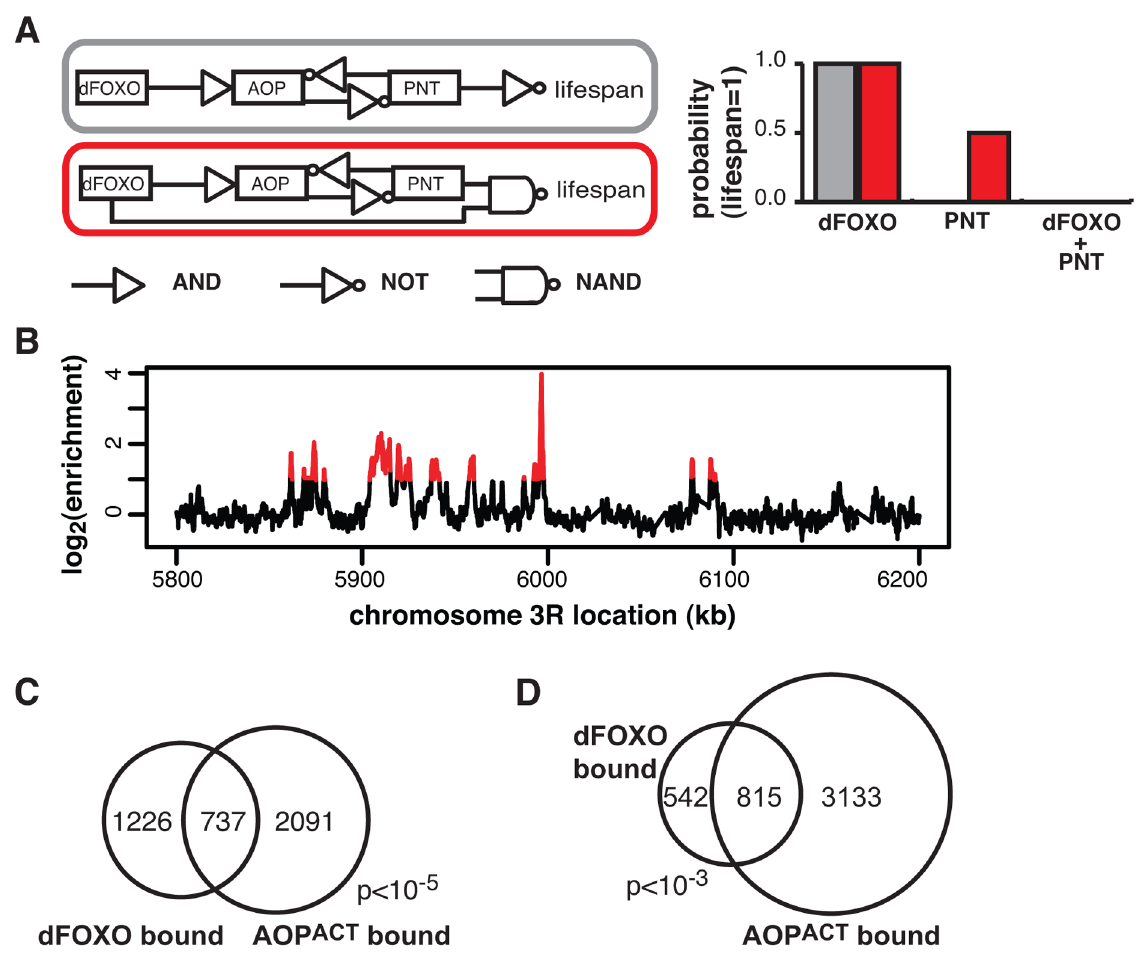
Figure 5. dFOXO and AOP ACT share binding sites across the genome. A Boolean network models of dFOXO-AOP-PNT-lifespan interaction. The linear model is indicated in grey and the feedforward model in red. The logic gate symbols for AND, NOT and NAND (NOT AND) are used, and in the case shown NAND means that only the combined effect of dFOXO and PNT is detrimental to lifespan. For each model the probability of a positive outcome for lifespan (lifespan=1; y axis) after 1000 state transition was determined using Markov chain simulations after fixing either dFOXO or PNT or both as active (=1; x axis). Only the feedforward model can capture the synergistic negative effects of the two TFs. B ChIP-chip traces, showing the enrichment (log 2 -transformed) of the FLAG-AOP ACT -immunoprecipitated DNA over total chromatin, are averages of three biological repeats after subtraction of the mock control and are shown over a region of chromosome 3R. Red denotes the enrichment associated with peak regions. C Proportional Venn diagram showing the overlap between the genes in the vicinity ( , 1 kb) of GFP-dFOXO or FLAG-AOP ACT binding in the gut/fat body (Hypergeometric test, p , 10 2 5 ). D Proportional Venn diagram showing the overlap in GFP-dFOXO-bound and FLAG-AOP ACT -bound genomic sites. Note that the average overlap is shown, since one peak in one set can overlap multiple peaks in the other due to differing peak lengths: 819 GFP-dFOXO-bound and 810 FLAG-AOP ACT -bound sites are in the overlap. Bootstrap analysis revealed the overlap as significant (p , 10 2 3